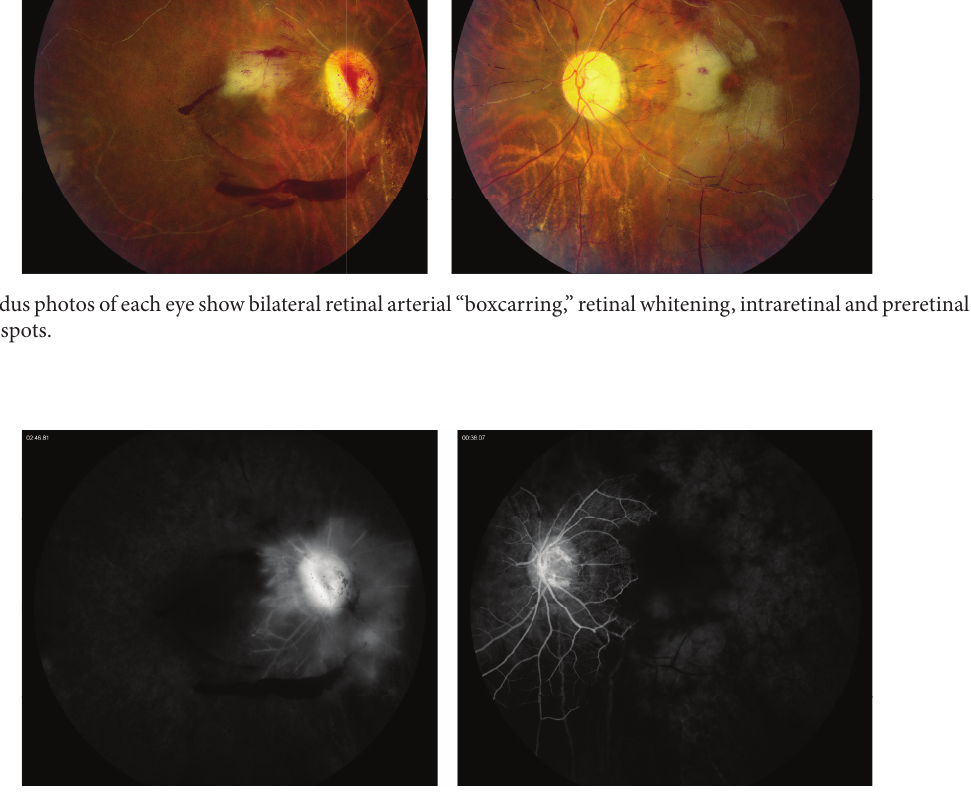
Figure 2: Fluorescein angiography of both eyes in the late phases shows minimal perfusion to the peripapillary areas with late leakage of the filling vessels.